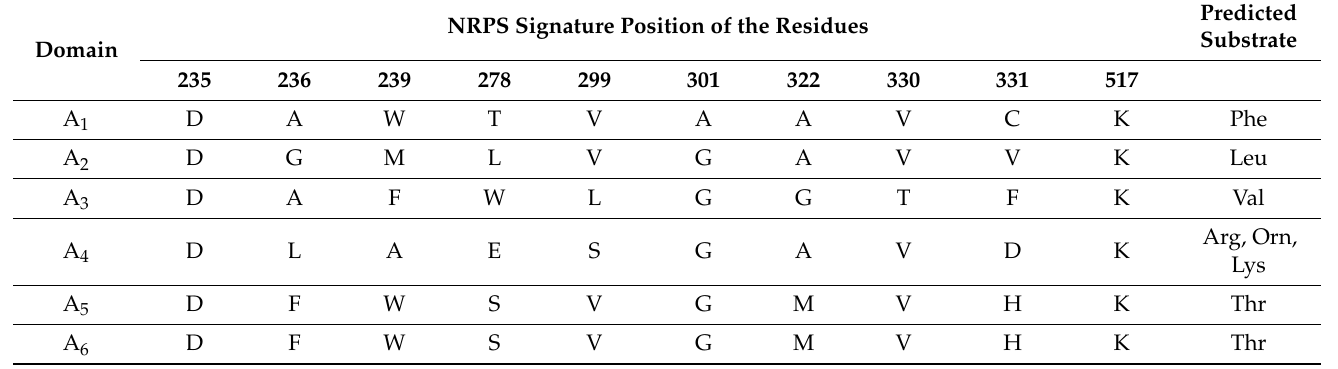
Table 3. Analysis of the adenylation domain